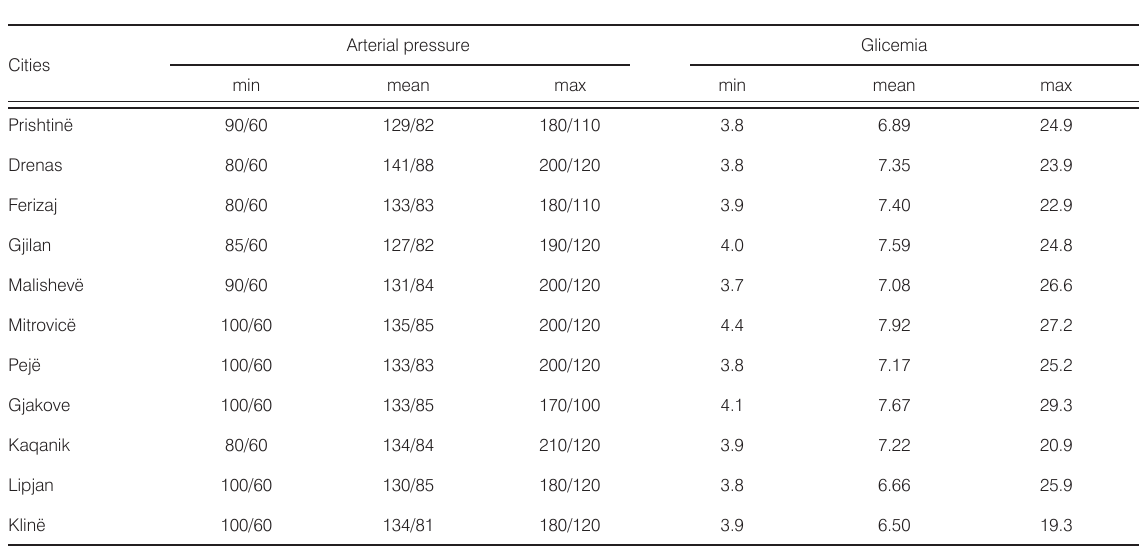
Table 4. Descriptive data for arterial pressure and glicemia as regards cities of Kosovo in